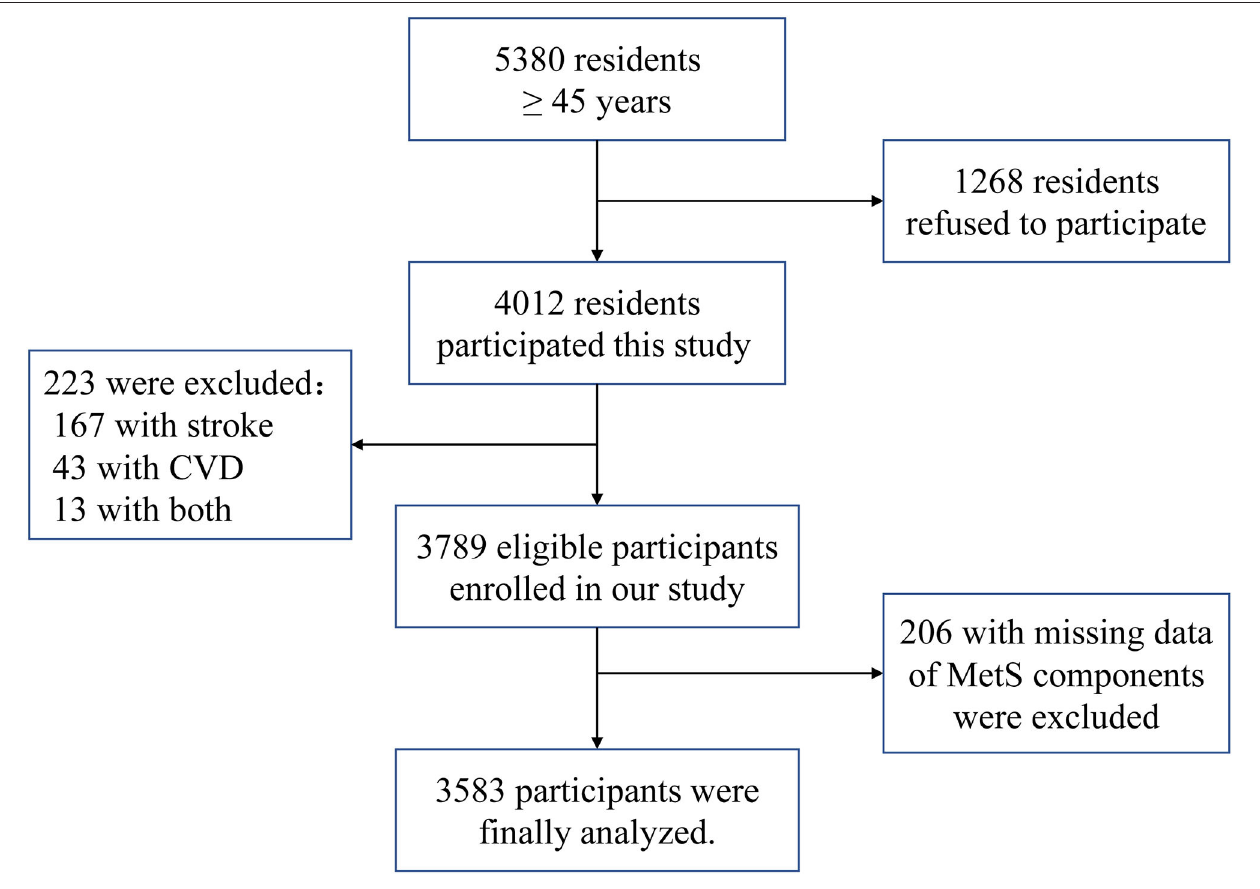
FIGURE 1 | The flow chart of participants